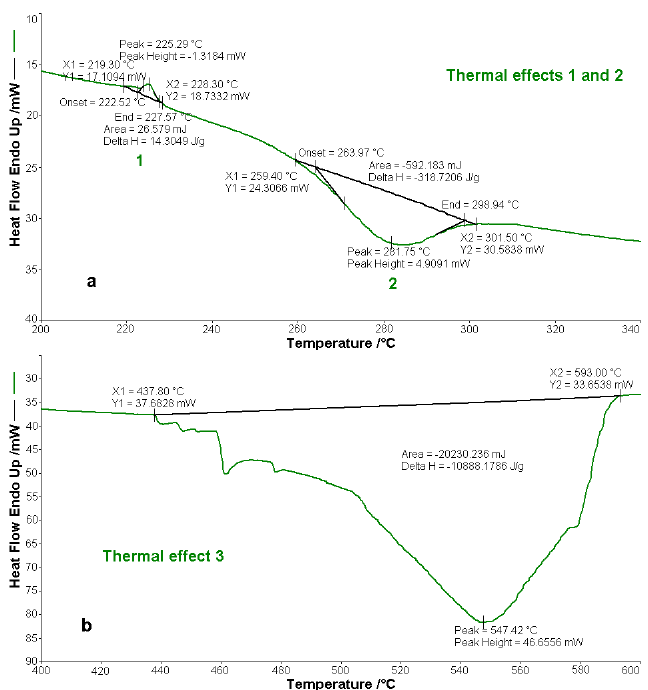
Figure 17. Thermal effects of decomposition of BTA in air: ( a ) thermal effect of melting (1) and thermal effect of the first decomposition (2), ( b ) thermal effect of the second decomposition (3).